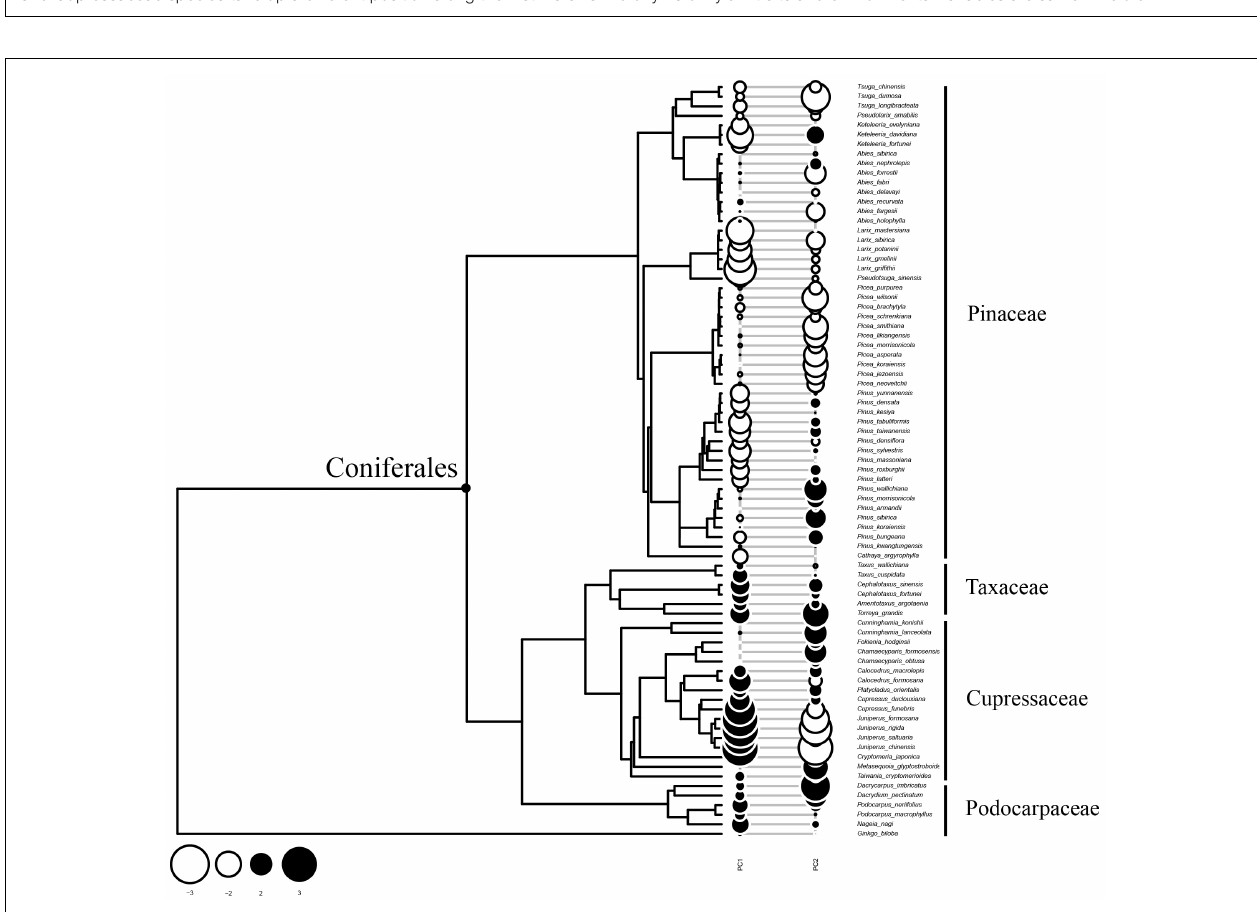
FIGURE 4 | Pattern of phylogenetic autocorrelation of tracheid dimensions along the phylotree. A bubble stands for Moran’ I values for each species. A coniferales label was added to emphasize two clades: Pinaceae species at the upper part of the phylotree and species of other families at the lower branches. Most of Pinaceae species showed negative phylogenetic autocorrelation values, suggesting that there are more frequent divergences in tracheid traits related with PC1. On the contrary, most of Cupressaceae species and others showed positive values, suggesting xylem structure were conserved for these species.